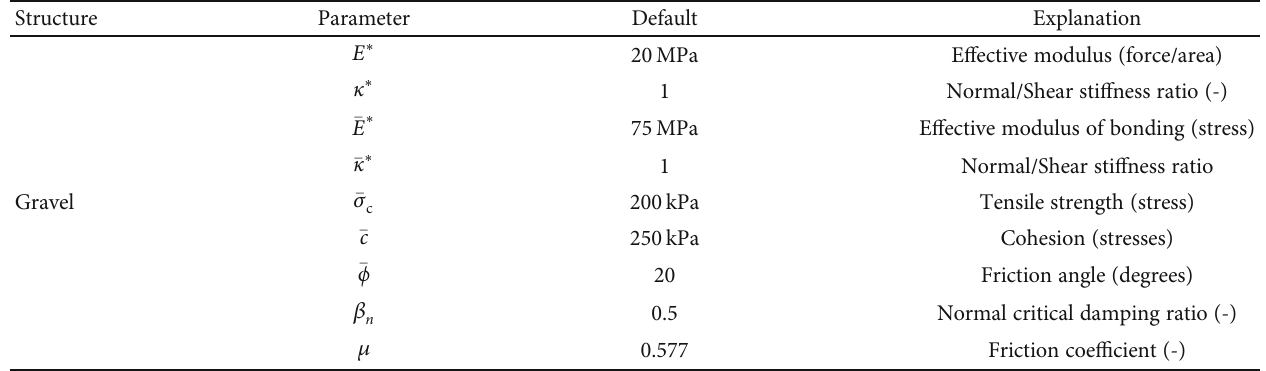
Table 2: Gravel simulation parameters.